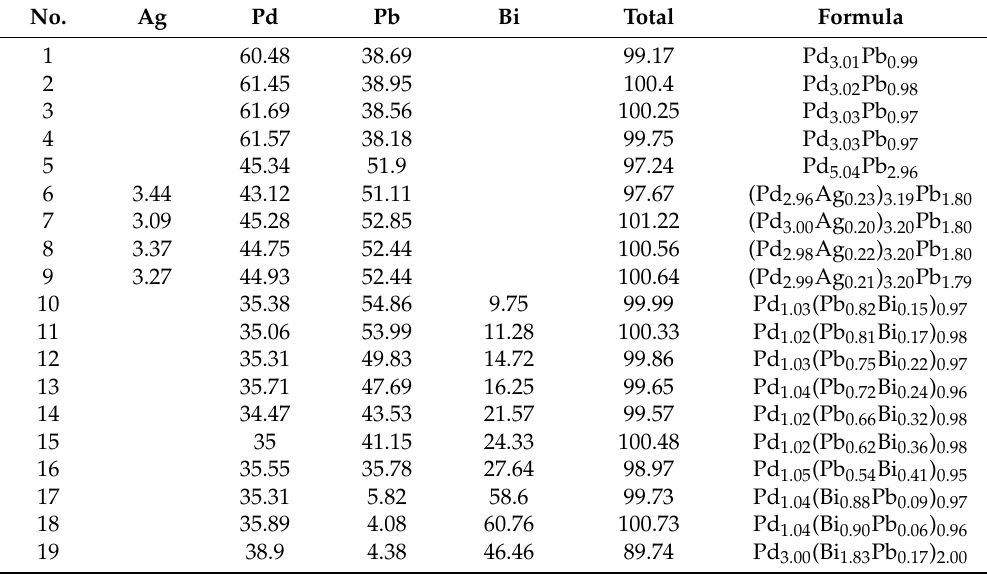
Table 7. Mineral compositions in system Pd-Pb-Bi in the Southern 2 orebody, wt %. No. Ag Pd Pb Bi Total Formula